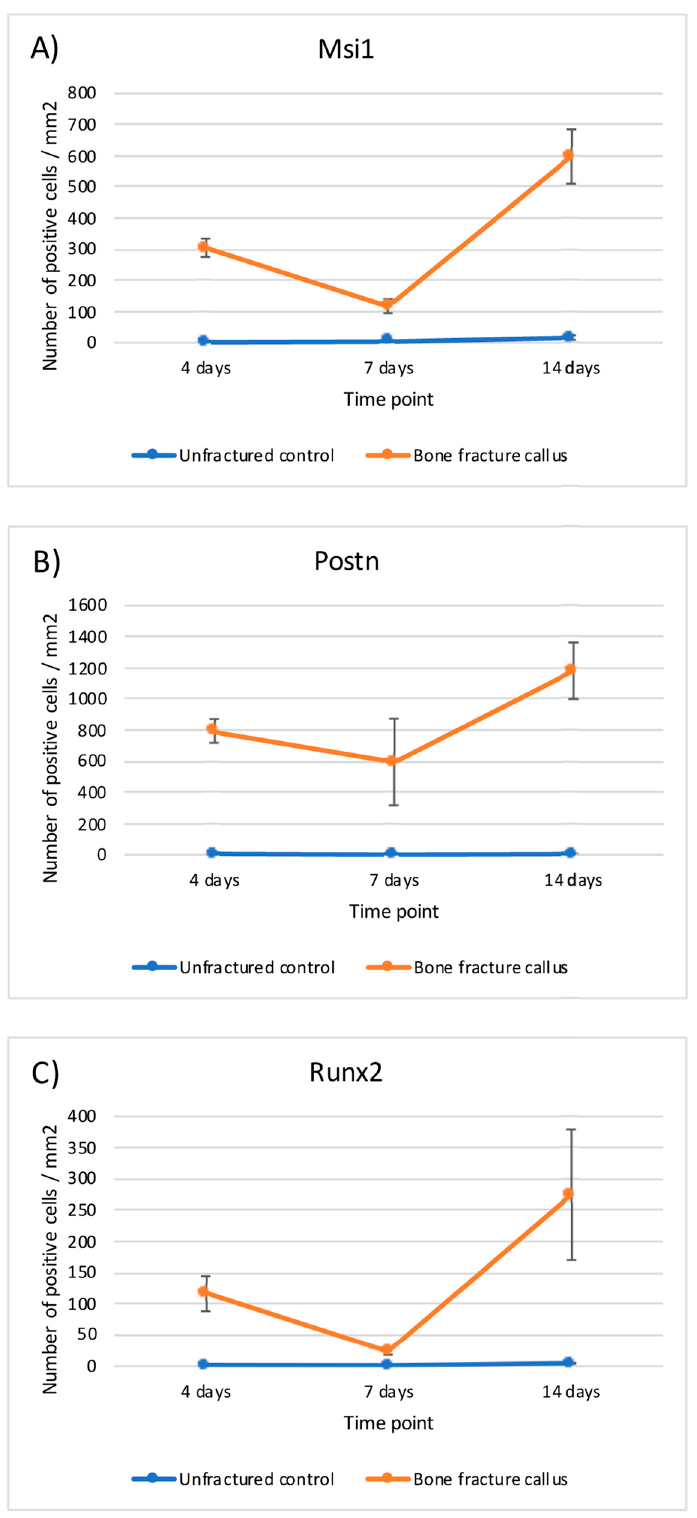
Figure 10. Graphical representation of the relative mRNA expression over time in bone fracture callus (orange line) and unfractured control areas (blue line) of ( A ) Msi1, ( B ) Postn and ( C ) Runx2.